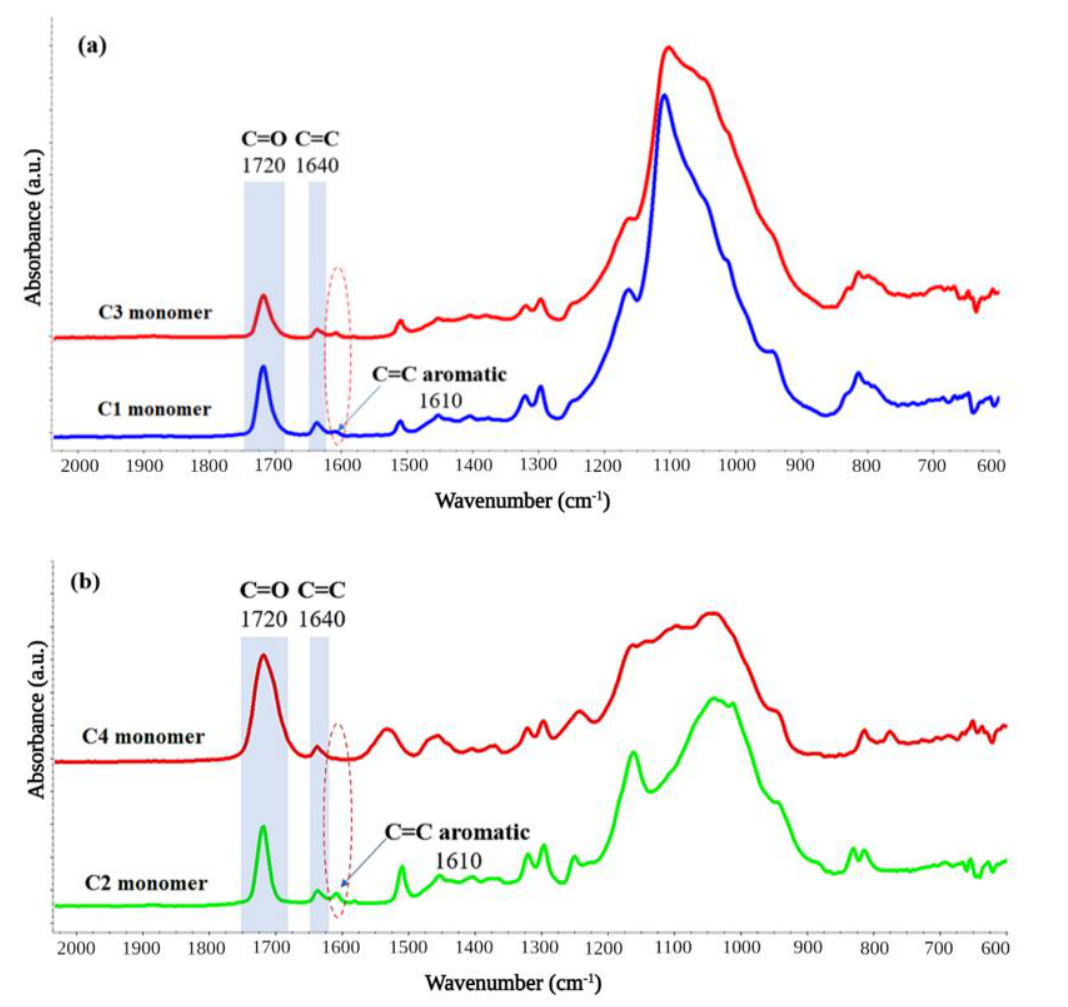
Figure 3. The FT-IR spectra of the ( a ) C1 and C3, and ( b ) C2 and C4 restorative dental materials before the crosslinking process.